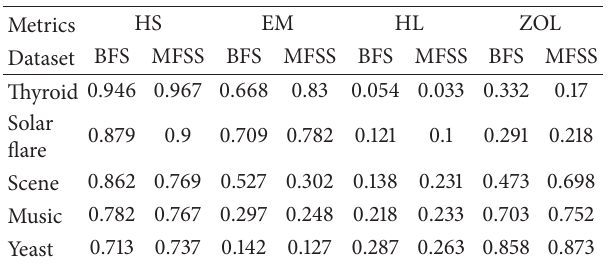
Table 3: Evaluation metrics for Naive Bayes algorithm.